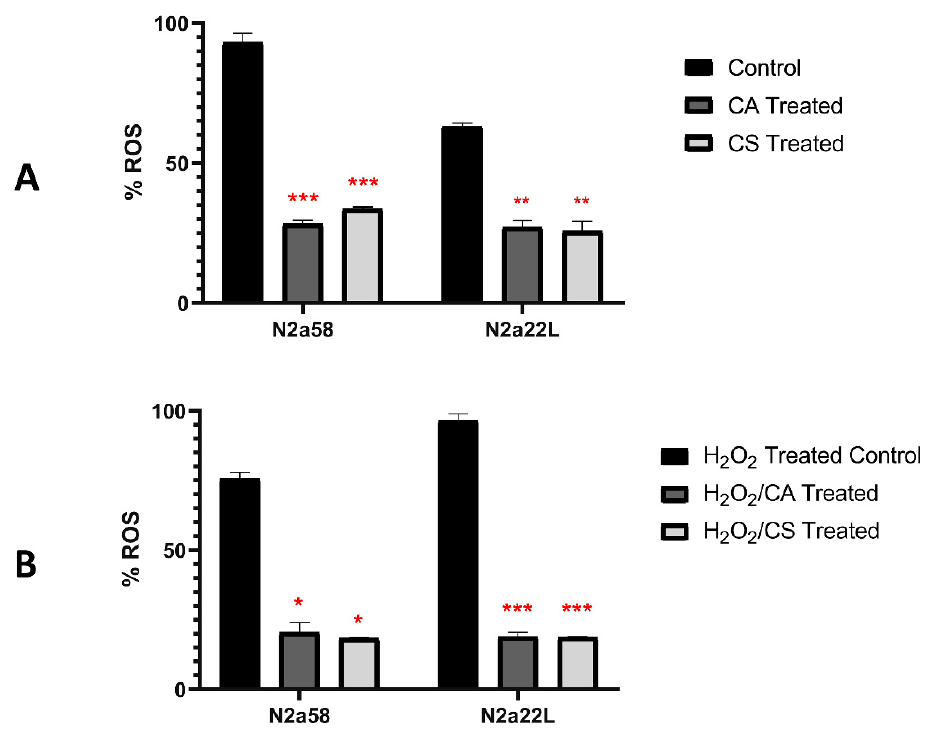
Figure 2. Reactive oxygen species (ROS) measured using H 2 DCFDA in N2a58 and N2a22L cell lines after treatment with the 0.5 × LD50 of Carnosic acid (CA) and Carnosol (CS) without ( A ) or following ( B ) pre-treatment with 600 μΜ H 2 O 2 (2 replicates for each condition). 0.5 × LD50 was estimated at 14.84 μΜ for CA and 16.53 μΜ for CS for N2a58 and at 13.58 μΜ CA and 12.85 μΜ CS for N2a22L. The % ROS was calculated based on the maximum ROS production value (3 mM). Data represent means ± SD; stars denote statistical significance (unpaired, one-tailed, T -test); *: p -value < 0.05, **: p -value < 0.01, ***: p -value < 0.001. CA: dark grey, CS: light grey, Control: black.